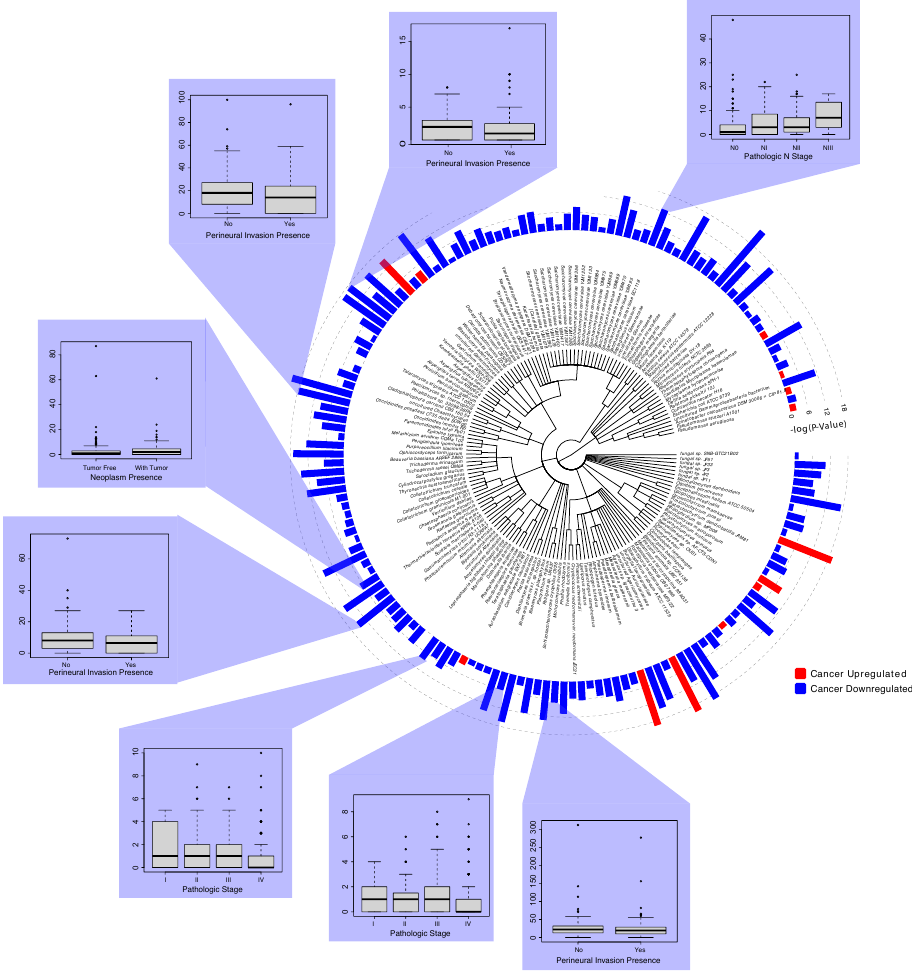
Figure 3. Differential abundance and clinical significance of microbes associated with tumor samples. Significantly dysregulated microbes in HNSCC primary tissue samples are displayed with associa- tions to clinical variables. Differential abundance correlations were conducted to compare microbial abundance between primary tumor samples and adjacent normal samples ( p -value < 0.05). Red corre- sponds to upregulation in cancer samples, while blue corresponds to downregulation in the cancer samples. Clinical variable comparisons were conducted for significantly dysregulated microbes using the Kruskal–Wallis tests in the edge-R library ( p -value < 0.05). The clinical variables investigated included pathological N-stage, perineural invasion presence, neoplasm presence, pathological stage, and vital